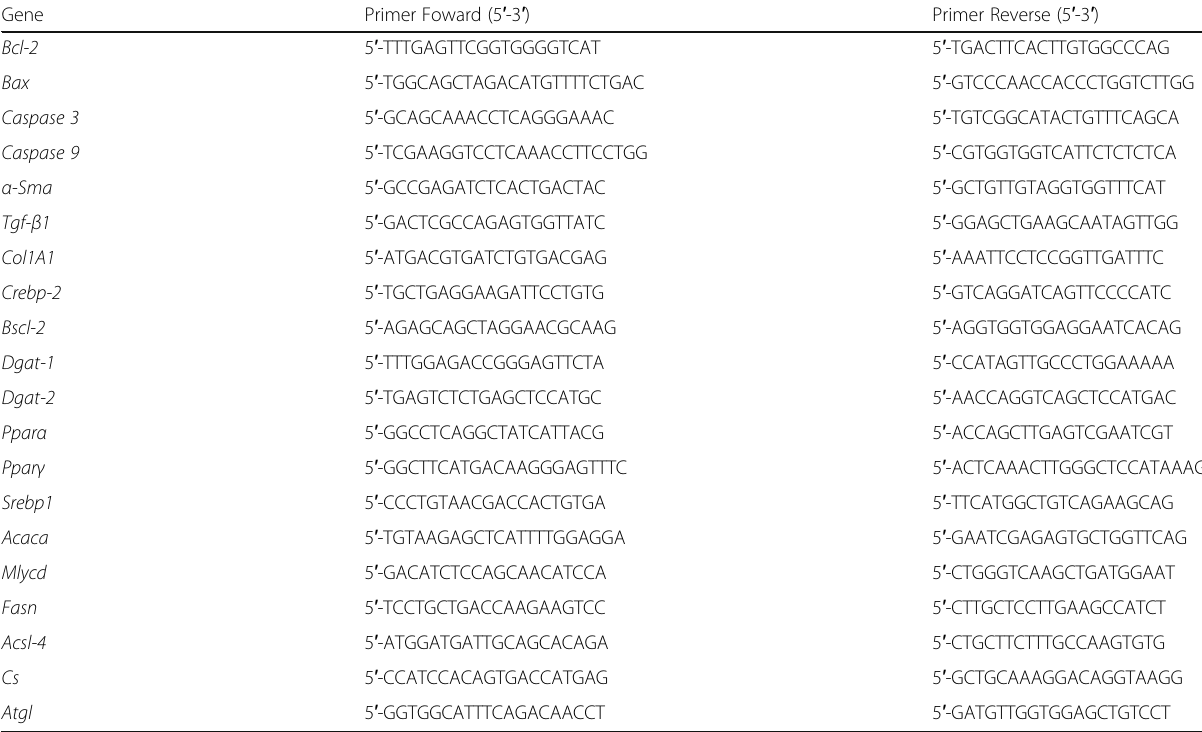
Table 1 Oligonucleotides sequences used in the assays Gene Primer Foward (5 ′ -3 ′